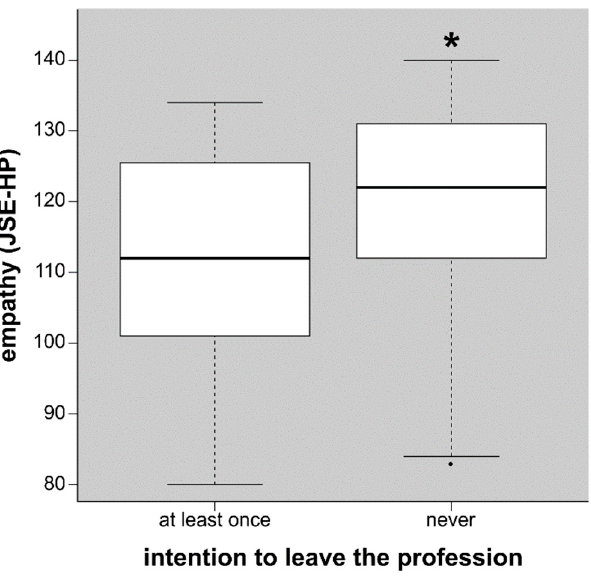
Figure 2. Scores of clinical empathy by the intention to leave the medical profession in Ecuadorian physicians who worked with COVID-19 patients. JSE-HP, Jefferson Scale of Empathy, Healthcare professional version. * p < 0.05. Outlier is represented by a